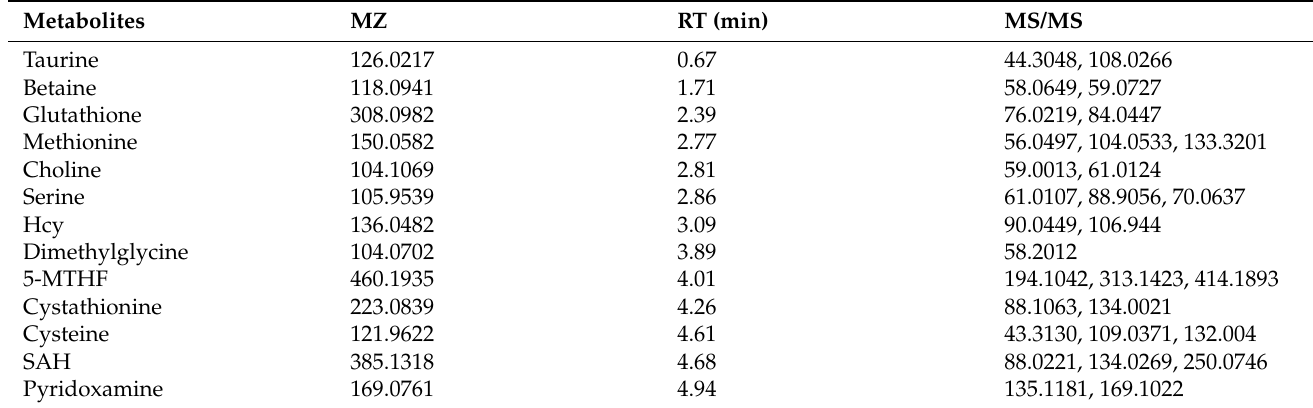
Figure 2. EIC plots of standards and samples detected by LC-QTOF-MS (( A ). Standards, ( B ). Samples). The metabolites shown from left to right are taurine, serine, cysteine, betaine, glutathione, Hcy, Methionine, choline, 5-MTHF, DMG, cystathionine, SAH, pyridoxamine. The metabolites marked in gray are those determined by the MS/MS information. Table 1. Qualitative confirmation of 13 related metabolites in Hcy metabolic pathways.